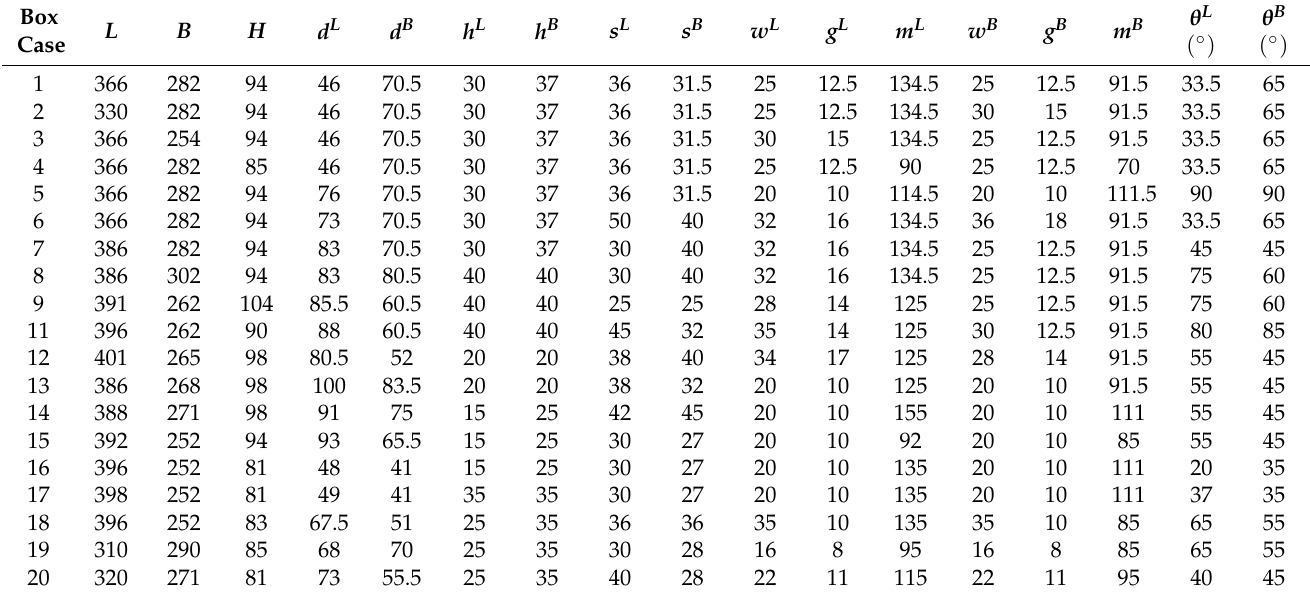
Table 1. Dimensions of selected packaging geometries; all parameter values, except the last two columns, are presented in